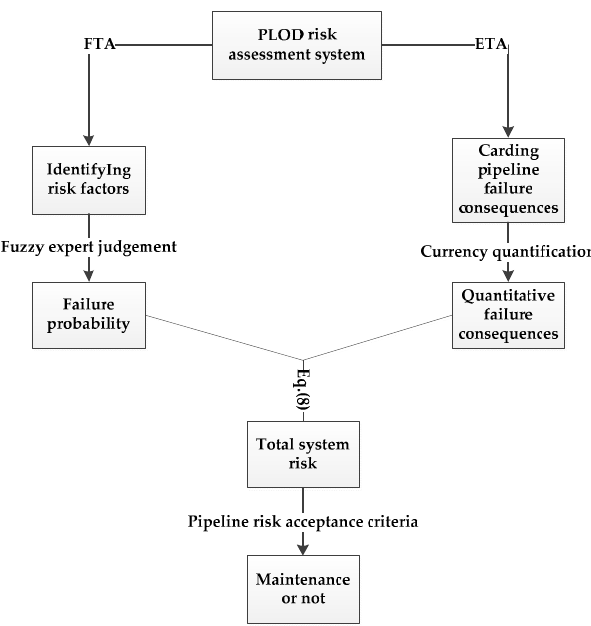
Figure 6. Pipeline property loss risk acceptable criteria. 352